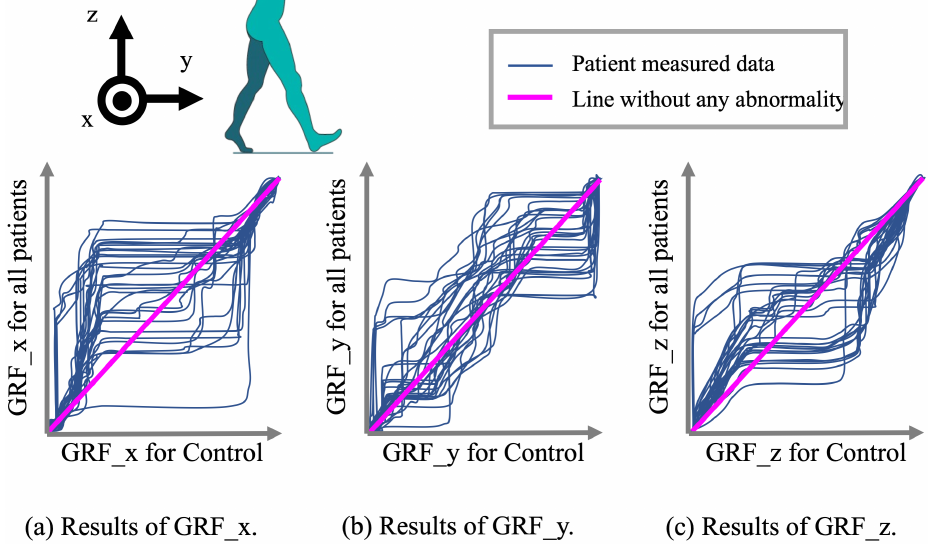
Figure 7. Results of accumulated cost matrices for all patients and warping path, which is expressed by dark-blue-colored curves: ( a ) represents the results of the x-axis ground reaction force (GRF_x), ( b ) represents that of the y-axis GRF_y, and ( c ) represents that of the z-axis